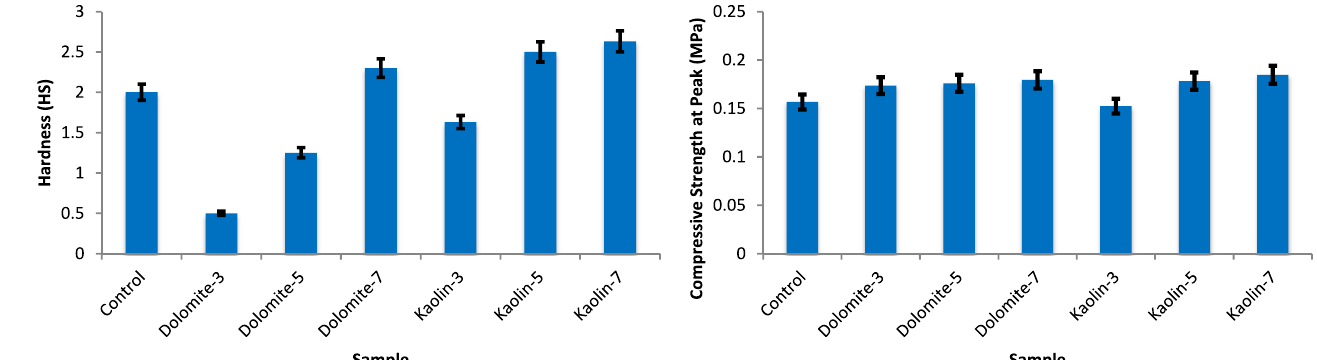
Fig. 6. Compressive strength at peak of the dolomite and kaoline fi lled polyurethane foam.